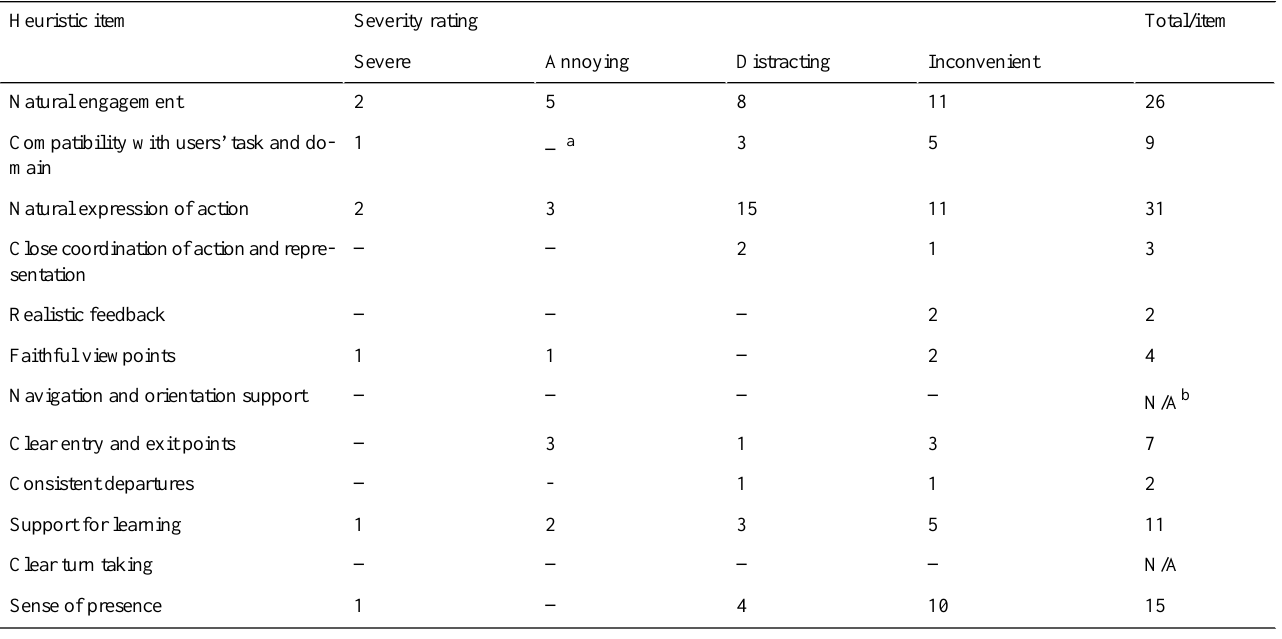
Table 2. Results of heuristic responses, noting the number of statements relevant to each item and the corresponding severity